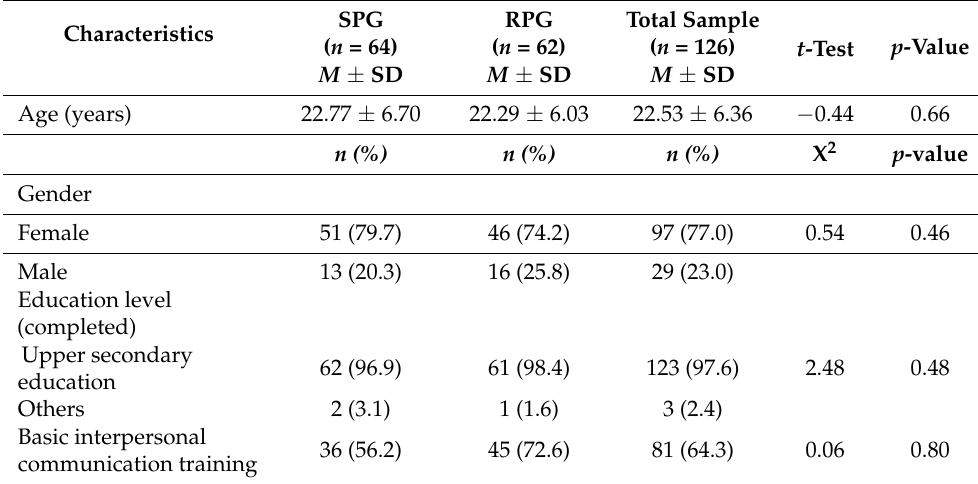
Table 1. Demographic characteristics of the study